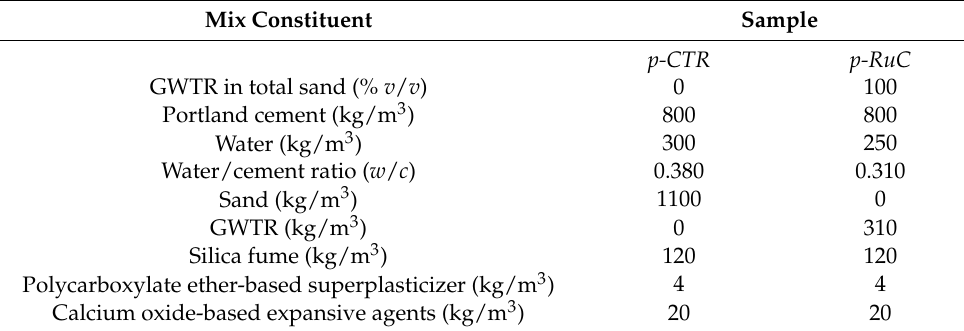
Table 2 details the mix compositions of the printable formulations under examination. Table 2. Mix proportions of printable formulations: p-CTR and p-RuC . Mix Constituent Sample p-CTR p-RuC GWTR in total sand (% v / v )